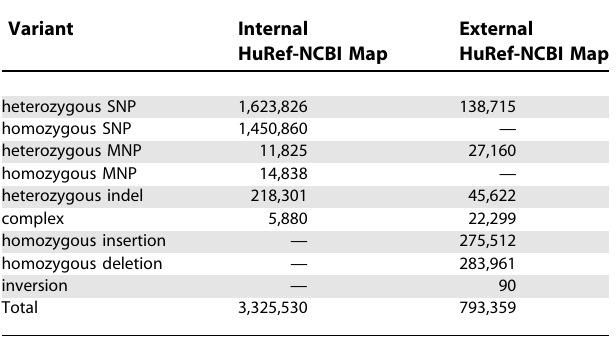
Table 4. Identification of Variants Found within the HuRef-NCBI One-to-One Assembly Map (Internal HuRef-NCBI map) and Those Variants in HuRef Sequence Not Aligned to NCBI (External HuRef- NCBI Map)